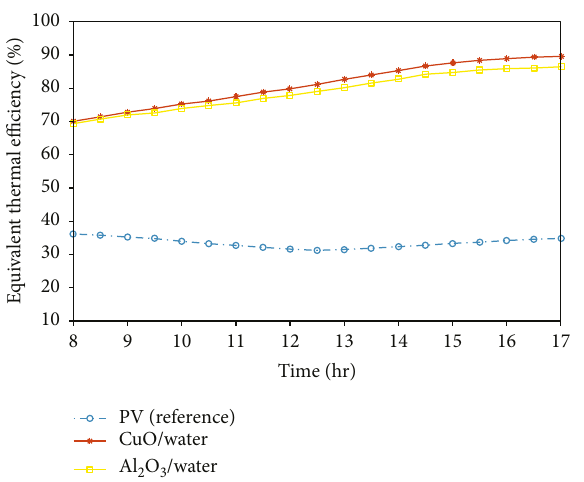
Figure 8: Daily variations of equivalent thermal e ffi ciency with reference PV, CuO/water, and Al